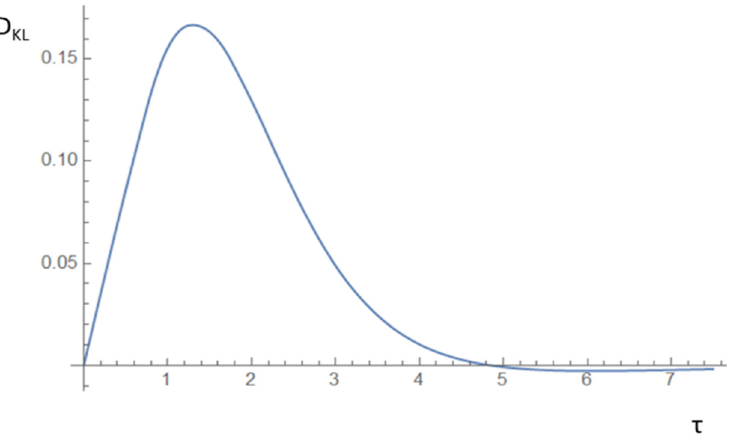
Figure 5. Kullback–Leibler distance (Equation (15)) between Green functions kernels as a function of time delay and v = 0.75 c . A small negative tail is spurious and is related to numerical approxi- mations.